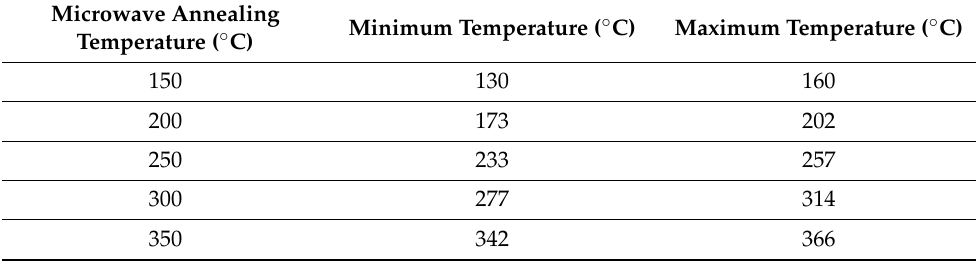
Table A1. Temperature deviation in microwave